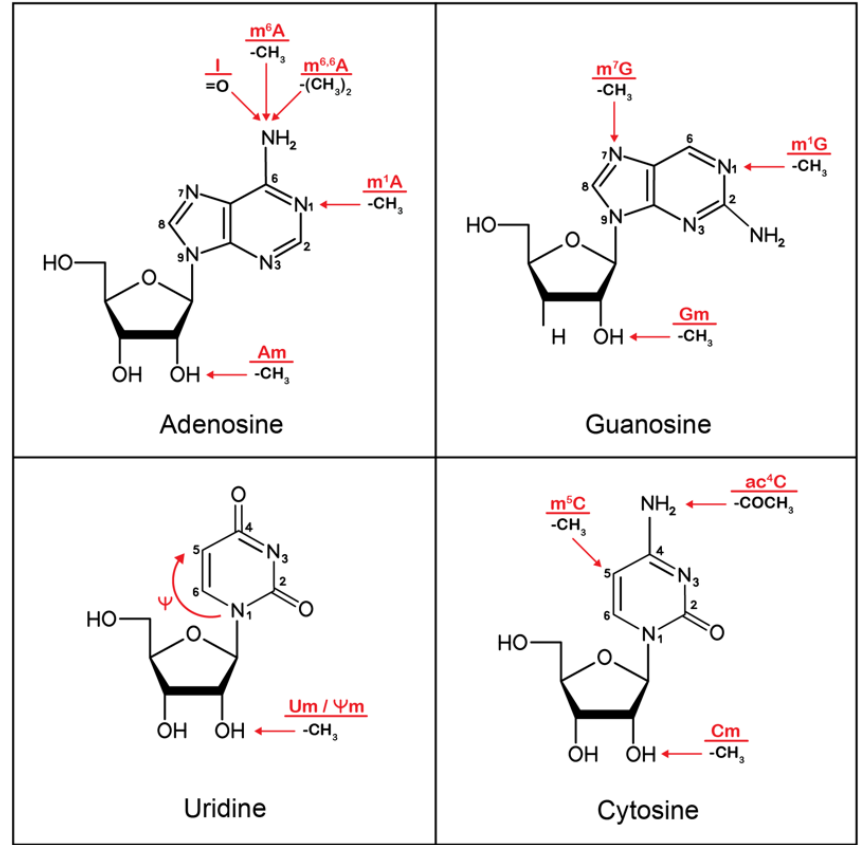
Figure 1. Major epitranscriptomic modifications. Each panel represents one of the four ribonucleotides. The precise locations of epitranscriptomic modifications predominantly found in mRNA are indicated with red arrows. The epitranscriptomic modifications are abbreviated in red, and the corresponding chemical group additions are indicated beneath. I: adenosine to inosine editing;